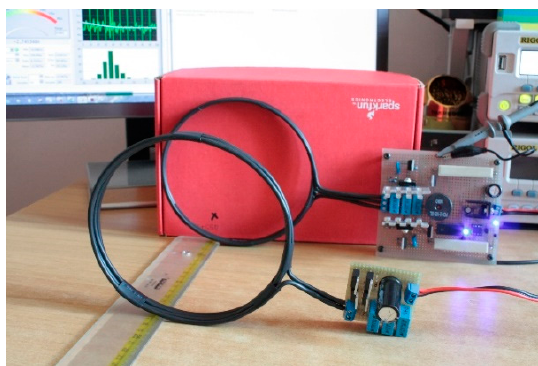
Figure 9. Inductive charging system test, free air.